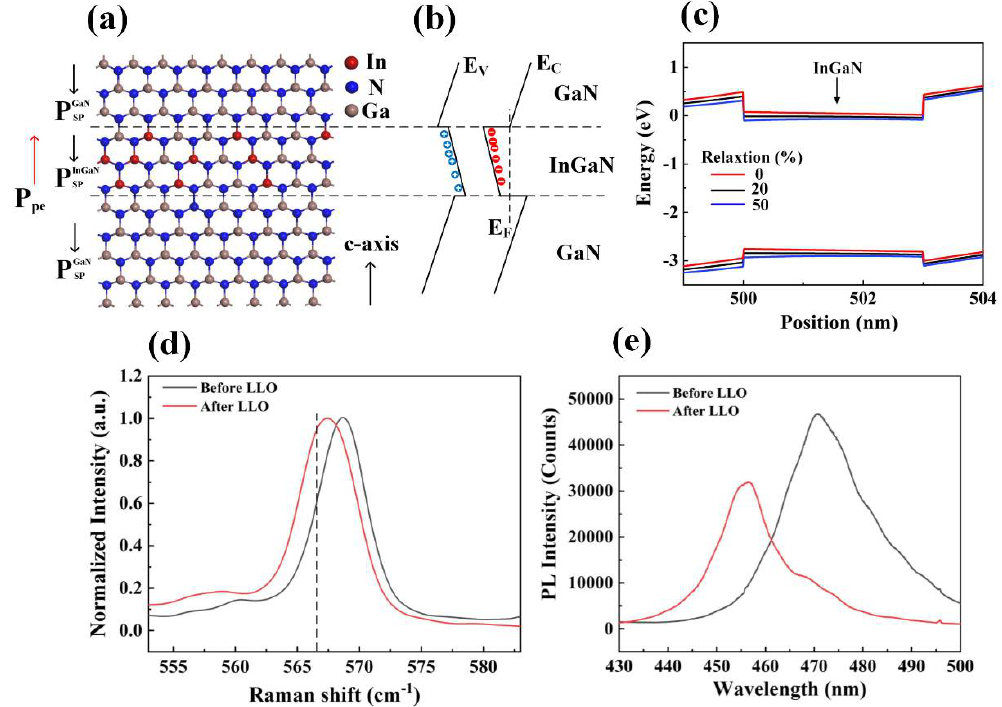
Figure 3. ( a ) Cross-sectional TEM, ( b ) atomic structure model, and ( c ) schematic energy band structure of the GaN/InGaN/GaN quantum well. ( d ) Normalized Raman spectra of the E2 (high) mode for the LED epilayers before and after laser lift-off (LLO). ( e ) PL spectra (T = 300 K) of the LED epilayers before and after LLO.